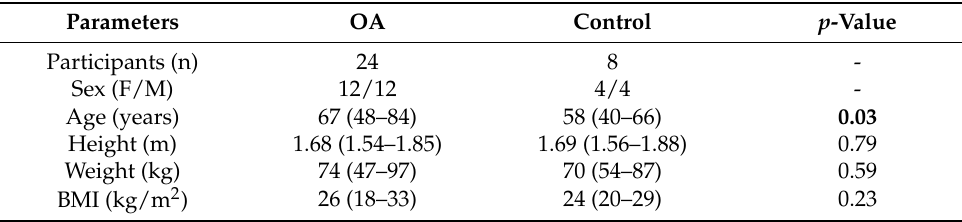
Table 1. Summary of participants’ demographics, reporting mean (range).